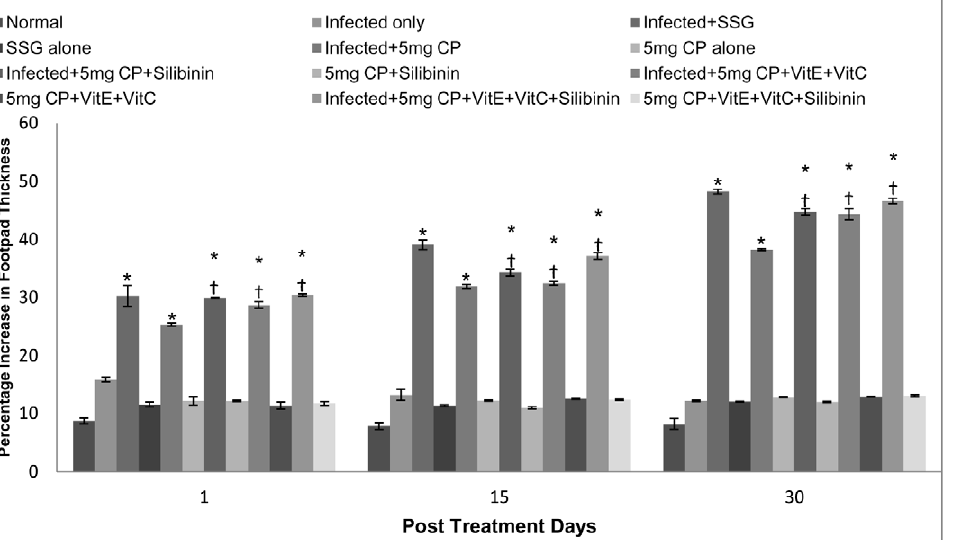
Figure 2. Percentage increase in footpad thickness (DTH response) in different groups of animals. The data are presented as mean 6 S.D. of six mice per group. * -p value: Infected only vs Infected + SSG/Infected + 5 mg CP/Infected + 5 mg CP + Silibinin/Infected + 5 mg CP + VitE + VitC/ Infected + 5 mg CP + VitE + VitC + Silibinin. { -p value: Infected + 5 mg CP vs. Infected + 5 mg CP + Silibinin/Infected + 5 mg CP + VitE + VitC/Infected + 5 mg CP + VitE + VitC + Silibinin. *, { -p ,